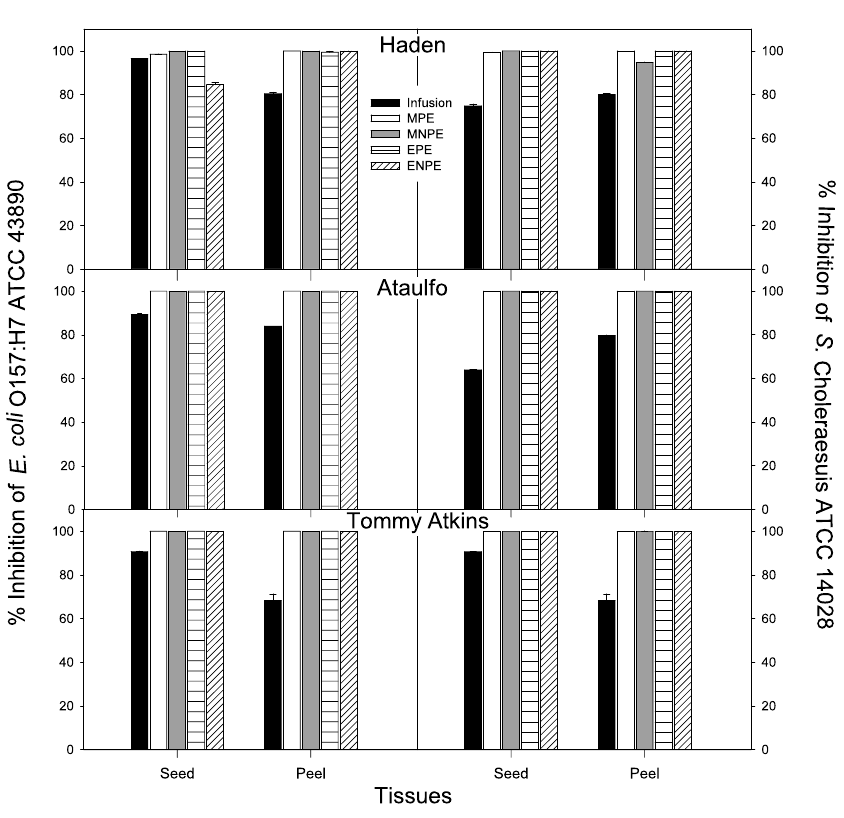
Fig. 4: Percentage of inhibition of gram negative bacterial strains exposed to bioactive extracts from fresh-cut mango byproducts. *Concentration 25 mg/mL. **Average of three determinations ± standard error.